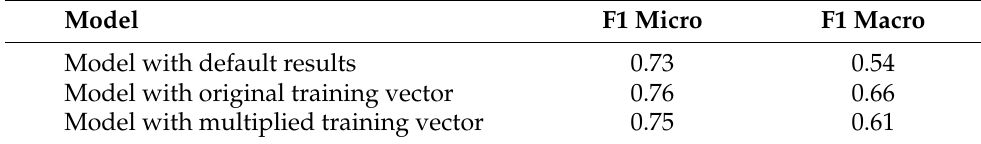
Table 13. F1 scores for the Custom Vision model on the validation set with different correcting